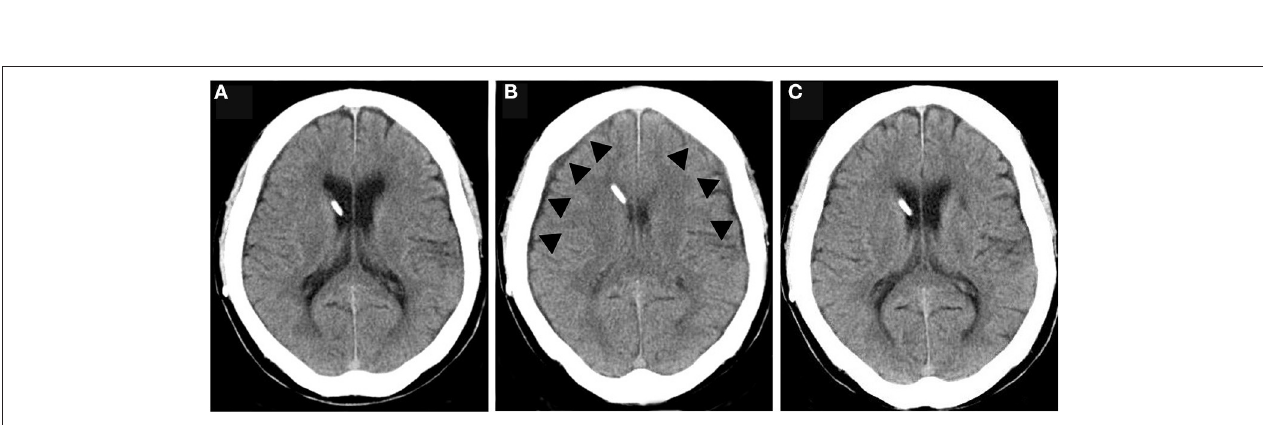
FIGURE 4 | The CSDH caused by overdrainage and disappearance after valve readjustment. (A) CT of normal drainage state after shunting; (B) CT during overdrainage reveal slit ventricle and thin CSDH (arrowhead); (C) CT At 1 month after the valve readjustment shows disappearance of CSDH and slit